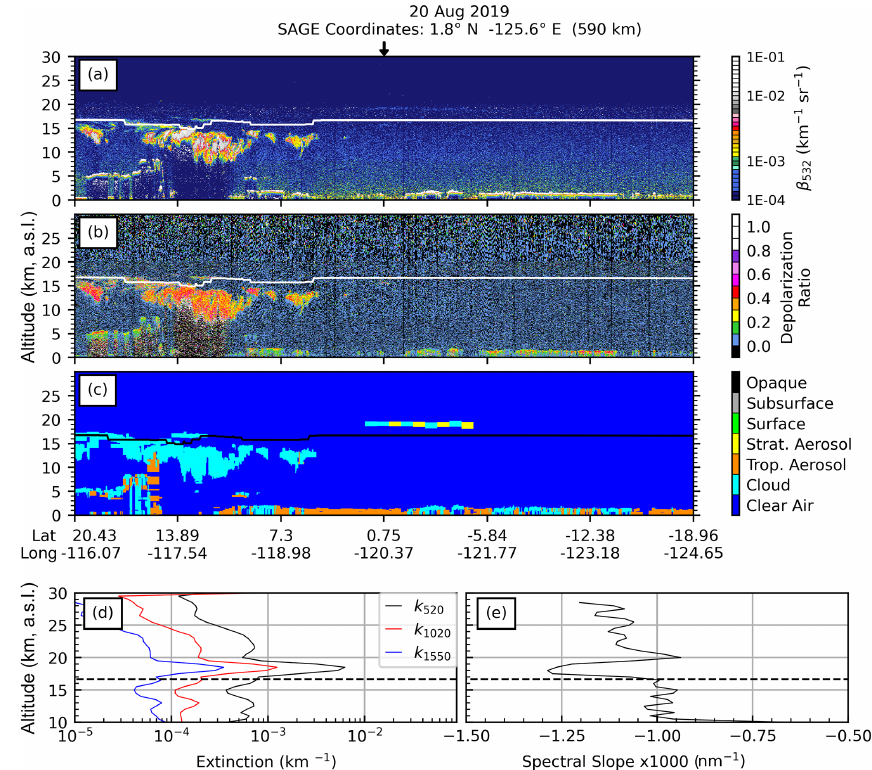
Figure 7. Same as Fig. 6, but for the Ulawun eruption. The CALIOP granule used to generate this image is CAL_LID_L1-Standard-V4-